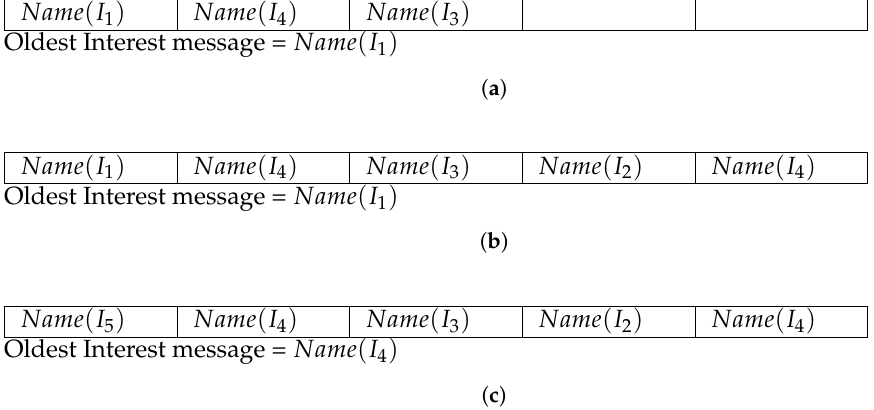
| ) = 5, | PT | = 5 ( after arrival of I R i R i 5